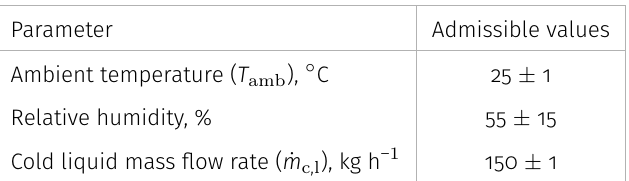
Table IV. Independent parameters kept fixed during the experimental